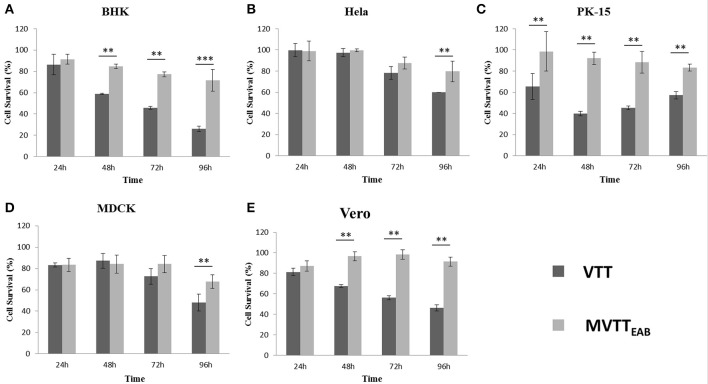
In vitro cytotoxicity of MVTTEAB and VVTT. BHK-21 (A), HeLa (B), PK-15 (C), MDCK (D), and Vero (E) cells were seeded in 96-well plates (1 × 104 cells/well) and infected with MVTTEAB and VVTT at an MOI of 0.5. Cell viability was measured every 24 h over a 96-h period. All measurements were performed in triplicate. Data are presented as the mean ± standard deviation (SD) values. When P < 0.01 (**) or P < 0.001 (***), the difference was considered to be significant.